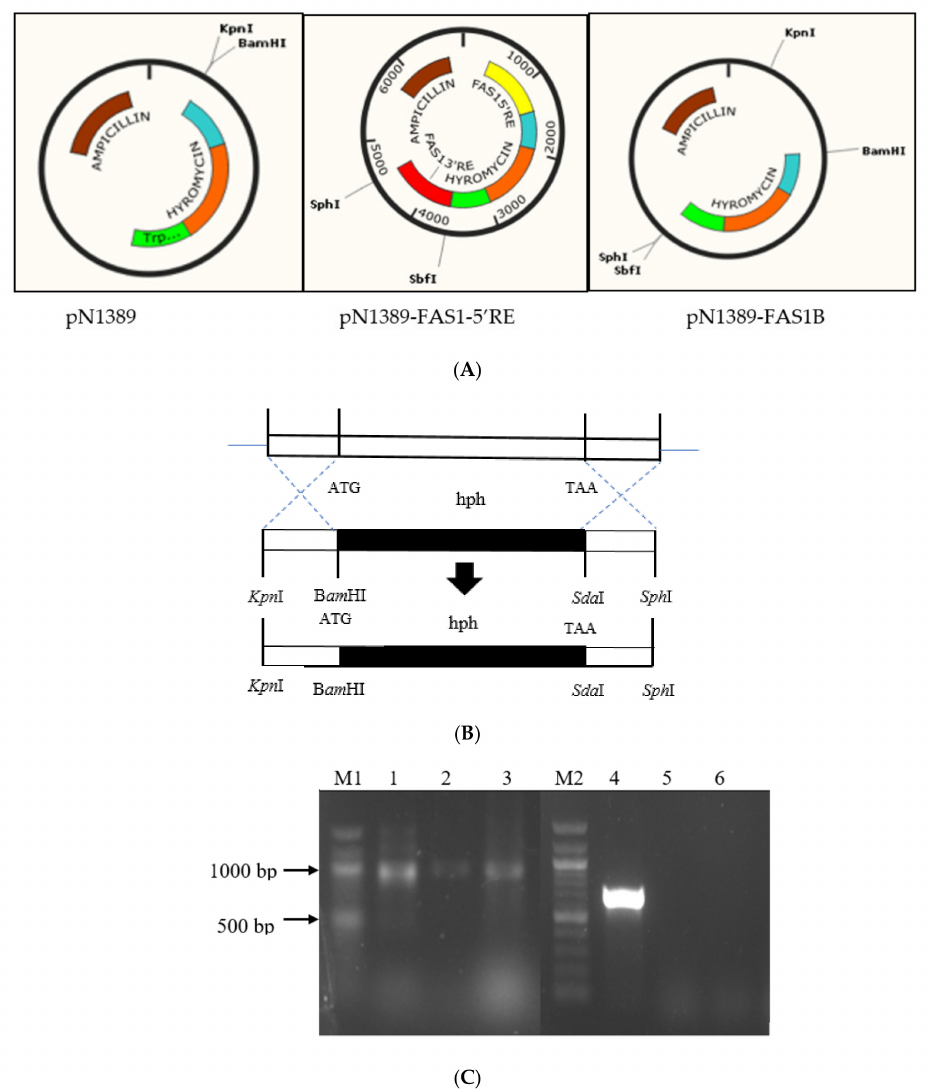
Figure 4. Schematic presentation of the FAS1 gene deletion process through homologous double crossover to generate the pN1389-FAS1 construct. Validation of putative transformants and protein visualization is provided. ( A ) Schematic diagram outlining the ligation of 5 (cid:48) FAS1 and 3 (cid:48) FAS1 with restriction sites into pN1389 plasmids. ( B ) Assembly of pN1389-FAS1-5 (cid:48) RE and pN1389-FAS1 formation. ( C ) Validation of mutants with hygromycin and fas1 gene primers. Lane M1 and M2: 1 kb ladder (Biolab, England), (a) Lane 1: pN1389 plasmid as a positive control (~1000 bp), (b) Lane 2: Transformant fas1-1 amplified with hygromycin primers (~1000 bp), (c) Lane 3: Transformant fas1-2 amplified with hygromycin primers (~1000 bp), (d) Lane 4: Genomic DNA wildtype amplified with fas1 gene primers (700 bp), (e) Lane 5: Transformant fas1-1 amplified with fas1 gene primers (no results), (f) Lane 6: Transformant fas1-2 amplified with fas1 gene primers (no results). Protein visualization via SDS-PAGE provided in the Supplementary Figure